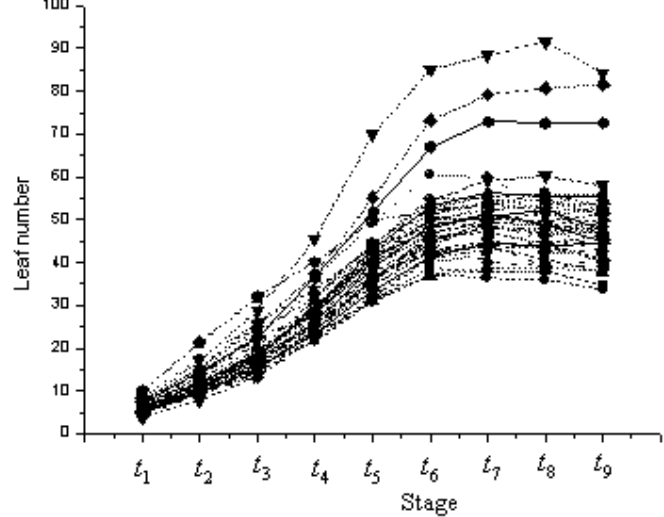
Figure 2. Development of dynamic variations in the leaf numbers for 39 genotypes. t i indicates the i th stage of the measurement.